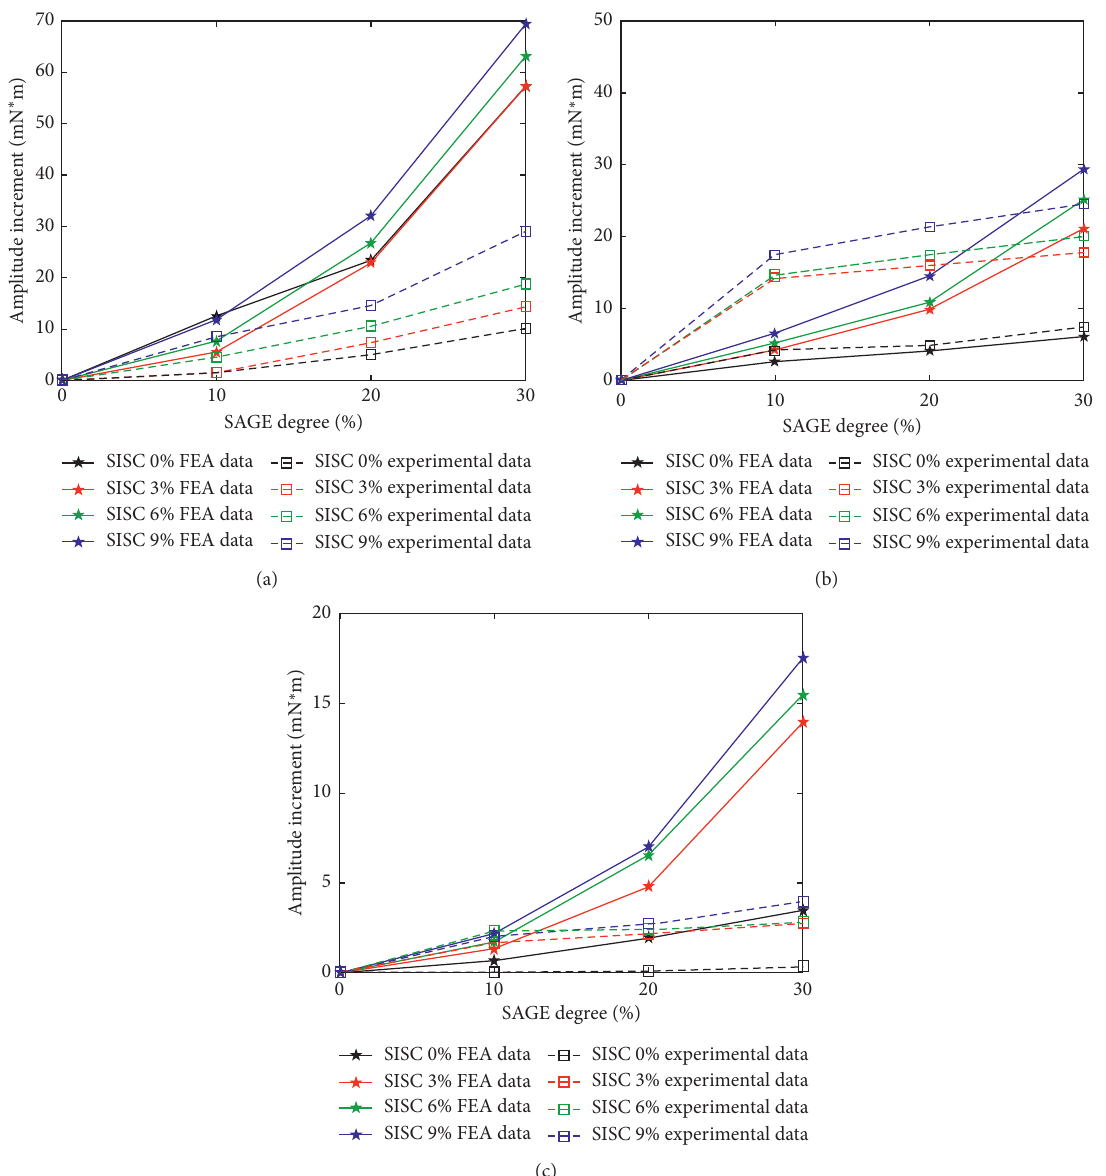
Figure 18: Impact comparison between CF and SAGE faults: (a) 2nd harmonic, (b) 4th harmonic, and (c) 6th